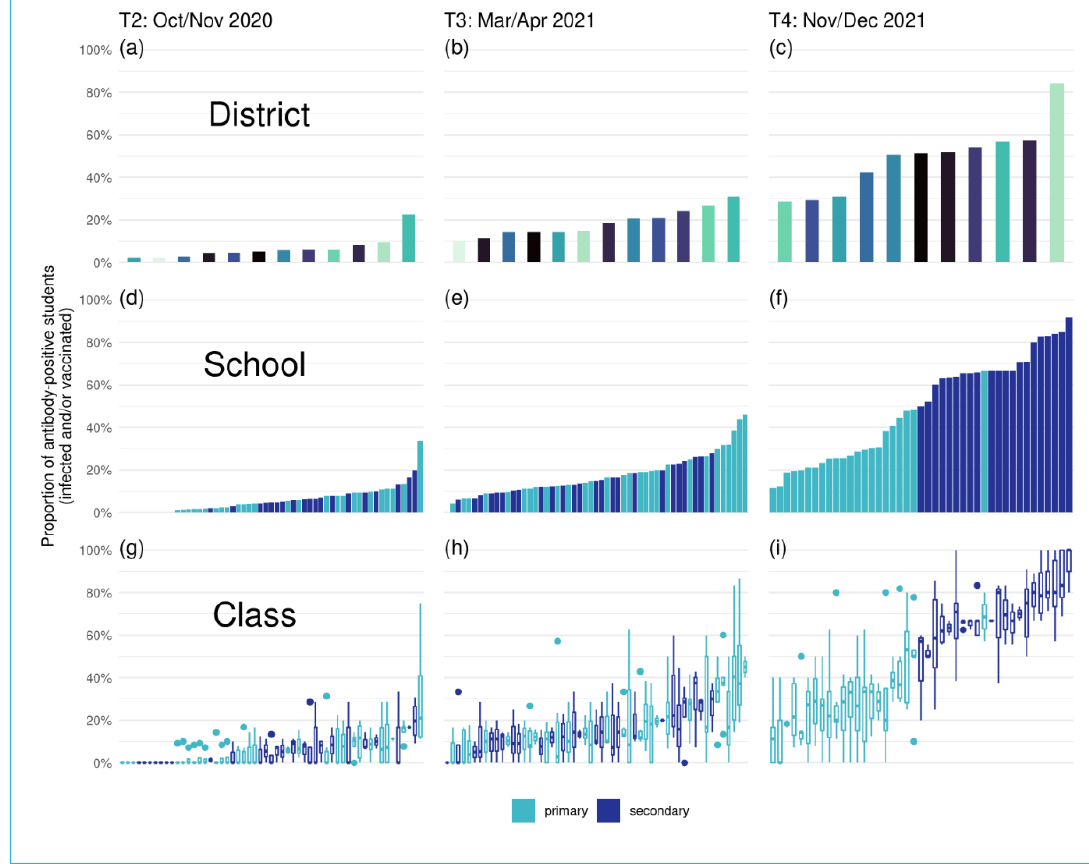
panels denote median and describe variability of seroprevalence on a school level expressed as maximum seroprevalence in a class minus minimum seroprevalence and summarised as median (interquartile range). Whiskers of boxplots denote ± 1.5 standard deviation